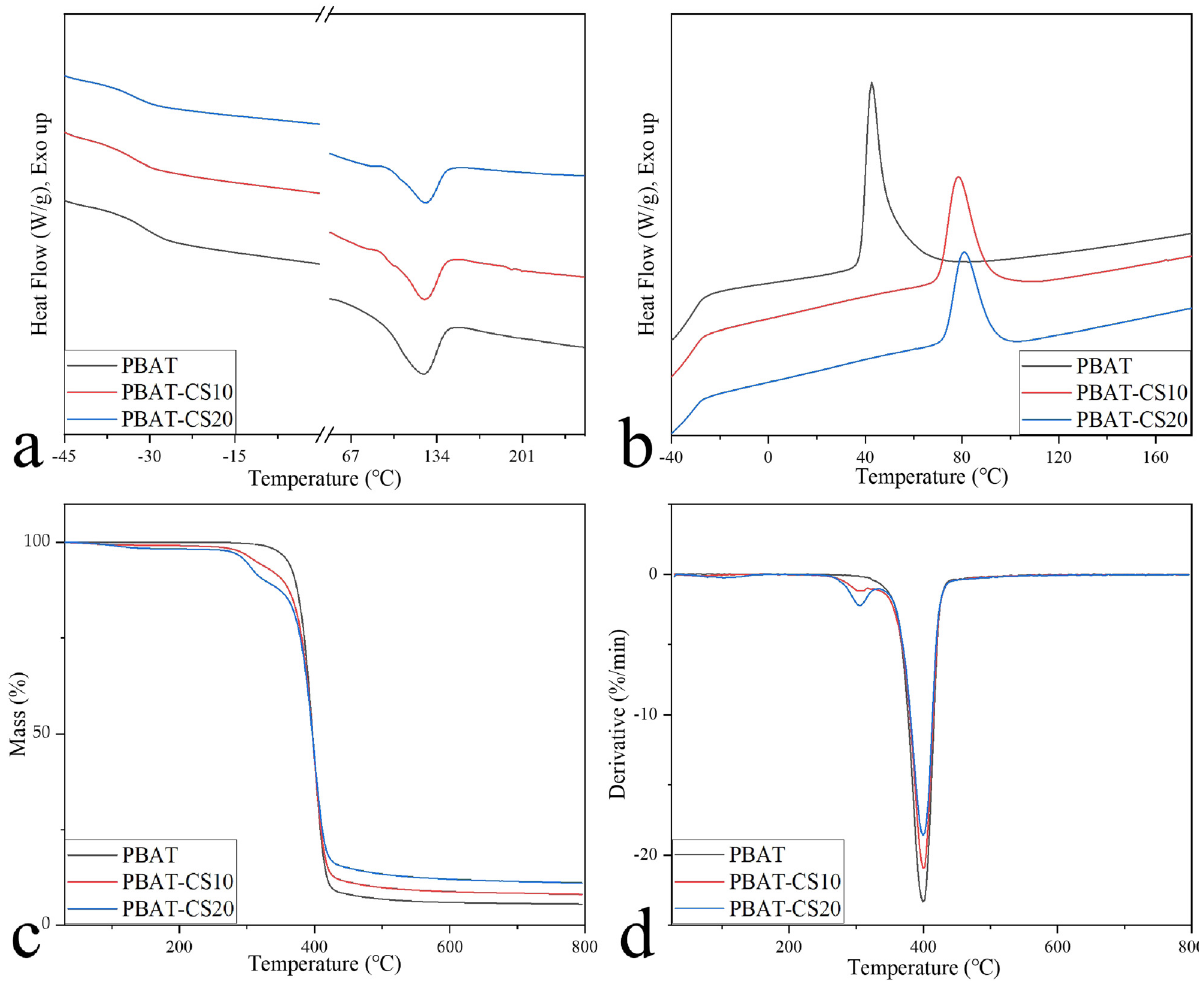
Figure 5: Thermal characterization of PBAT, PBAT - CS10, and PBAT - CS20: ( a ) DSC secondary heating curves, ( b ) DSC cooling curve, ( c ) TGA curve, and ( d ) DTG curve.